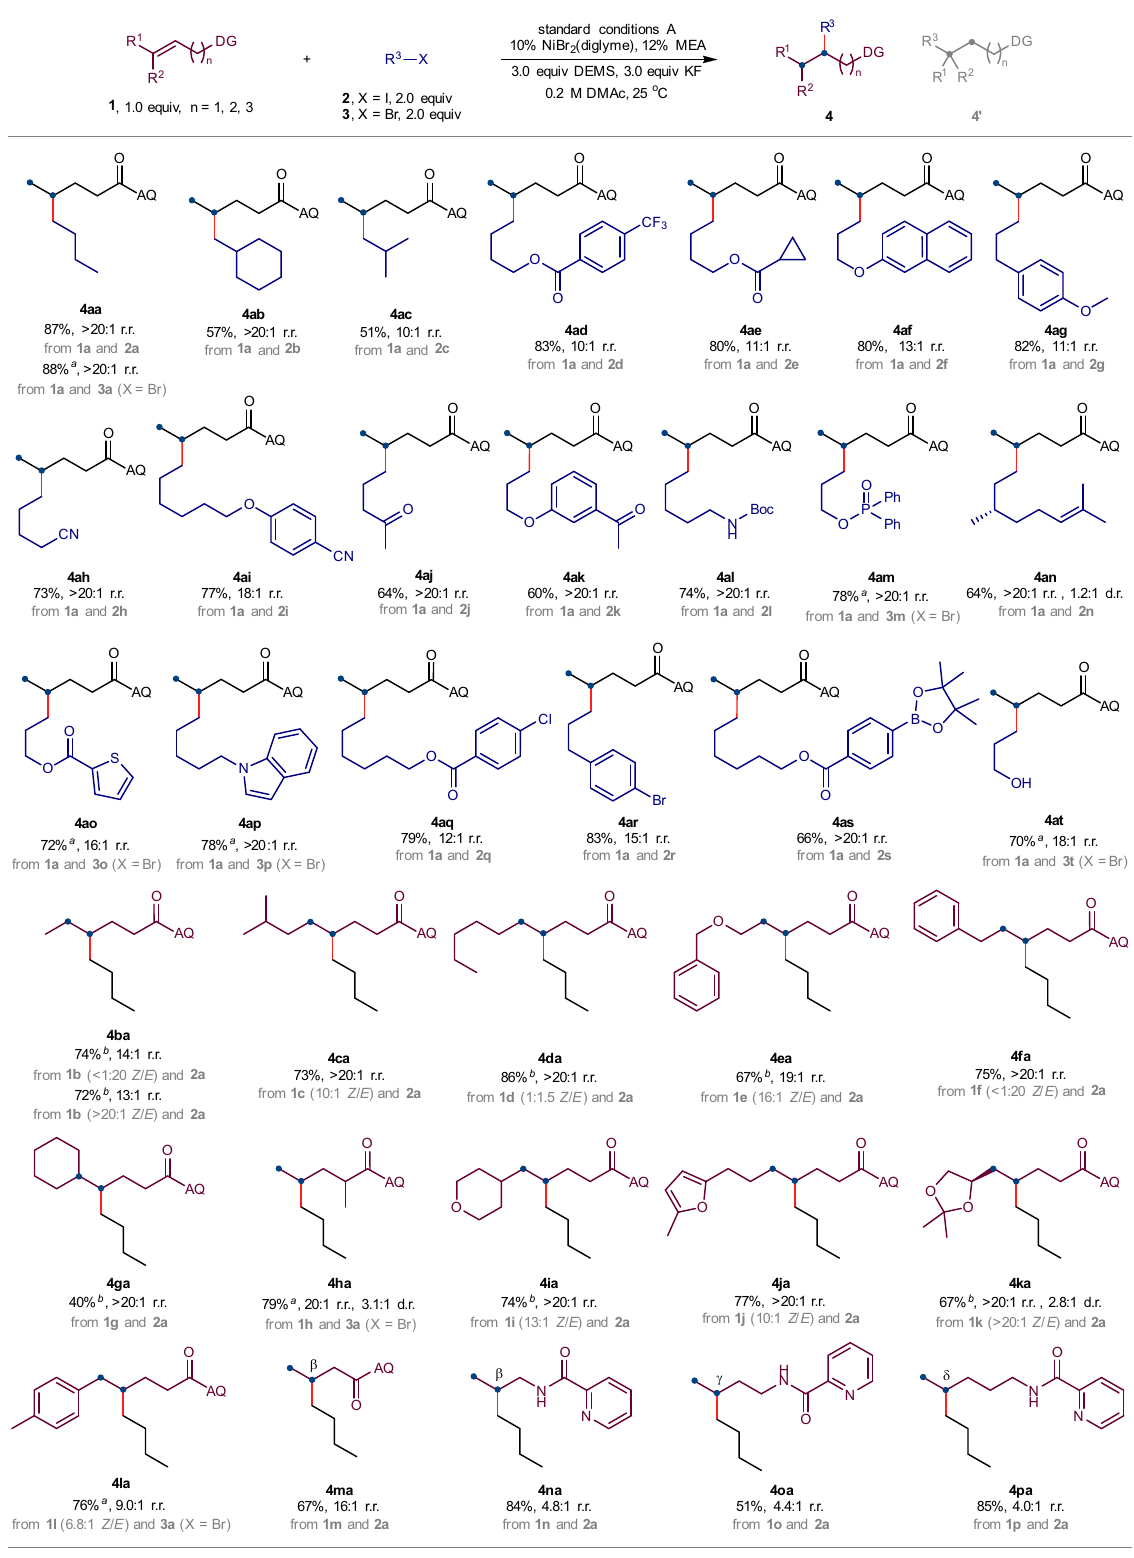
Fig. 2 Scope of proximal-selective hydroalkylation. Standard conditions A: alkene (0.20 mmol, 1.0 equiv), alkyl halide (0.40 mmol, 2.0 equiv), NiBr 2 (diglyme) (0.02 mmol, 10 mol%), MEA (0.024 mmol, 12 mol%), DEMS (0.60 mmol, 3.0 equiv), KF (0.60 mmol, 3.0 equiv), DMAc (1.0 mL, 0.2 M), 25 °C, 12 h, isolated yield. r.r. was determined by GC or 1 H NMR analysis. r.r. refers to the regioisomeric ratio, that of the major product to the sum of all other isomers. Proximal-selective hydroalkylation product was obtained as the major regioisomer, and distal-selective hydroalkylation product as the minor regioisomer; other regioisomers could hardly be detected. a NaI (0.10 mmol, 0.5 equiv) was added. b 40 °C. d.r. diastereomeric ratio, DG directing group.